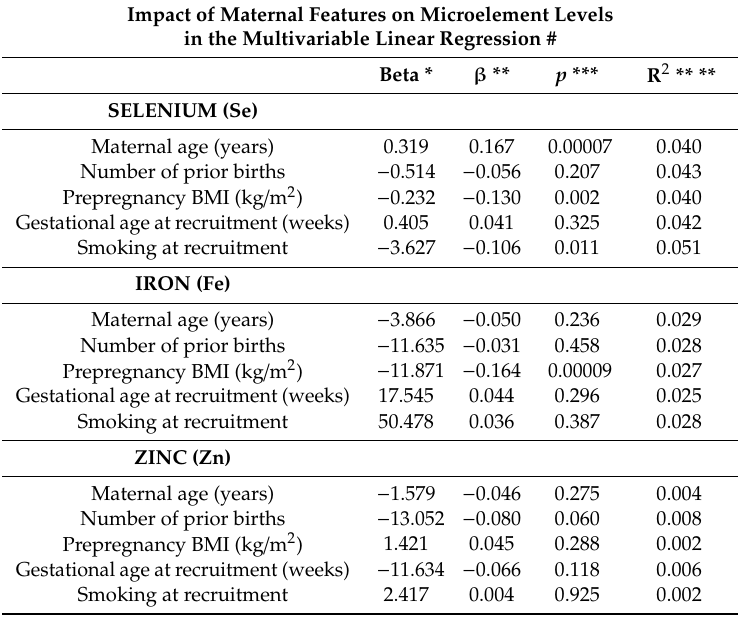
Table 3. The adjusted relationships between maternal features and microelement